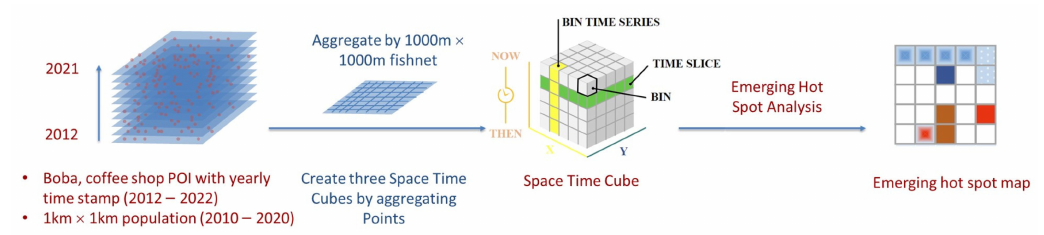
Figure 4. The working process of emerging hot spot analysis.